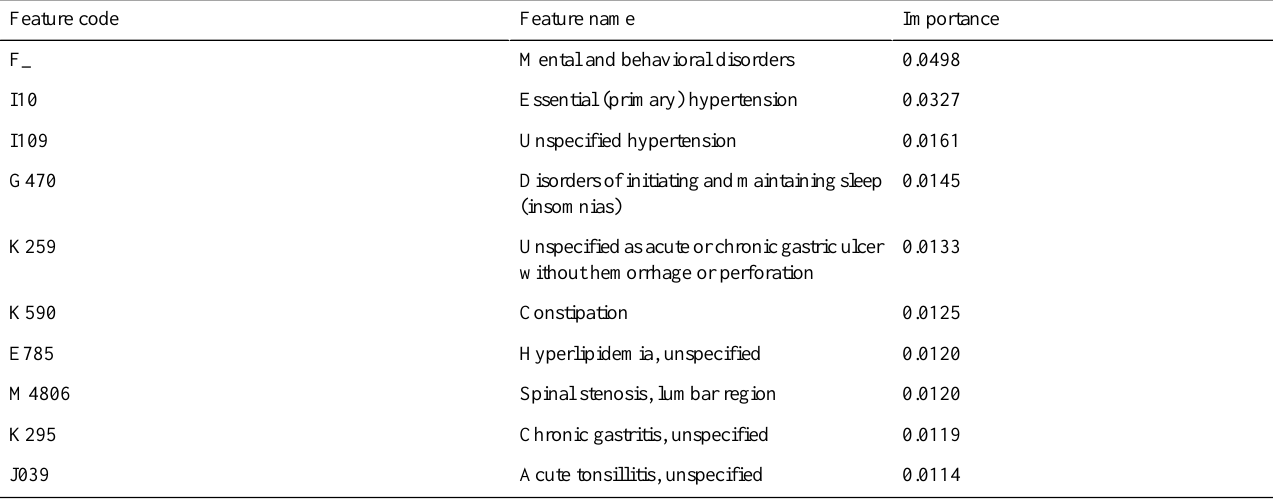
Table 3. Top 10 features in terms of importance when using only disease diagnostic data.